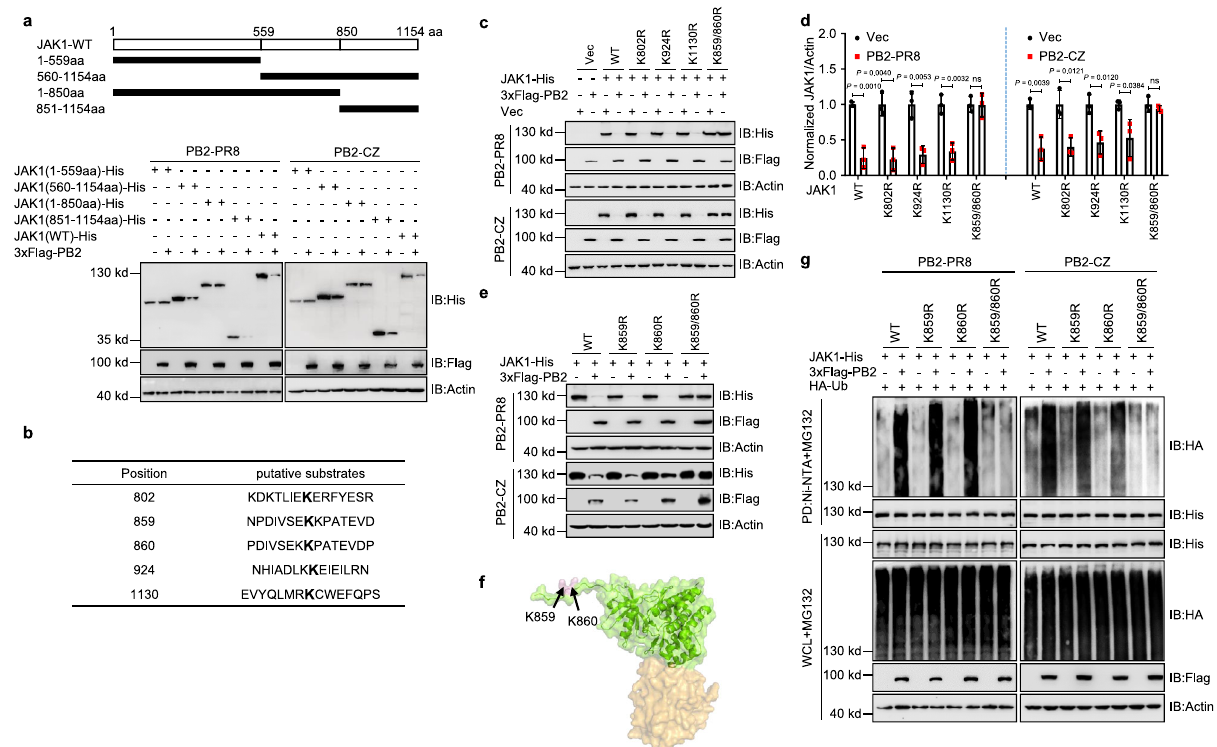
Fig.4|PB2-mediatedJAK1degradationatresidues859Kand860K.a Schematic representation of the deletion mutants of JAK1 (upper) and immunoblots of HEK293T cells transfected with JAK1 or its deletion mutants and PB2 plasmids (lower). b Ubiquitination modi fi cation online prediction of JAK1 by CPLM 1.0. c Immunoblots of HEK293T cells transfected with JAK1 or its mutants and PB2 plasmids. d Intensities analysis of the bands on the immunoblots (c) from three independent experiments. Data are presented as the mean±SD and